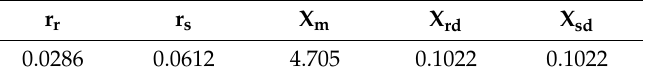
Table 1. Initial parameters values (IP) in p.u.